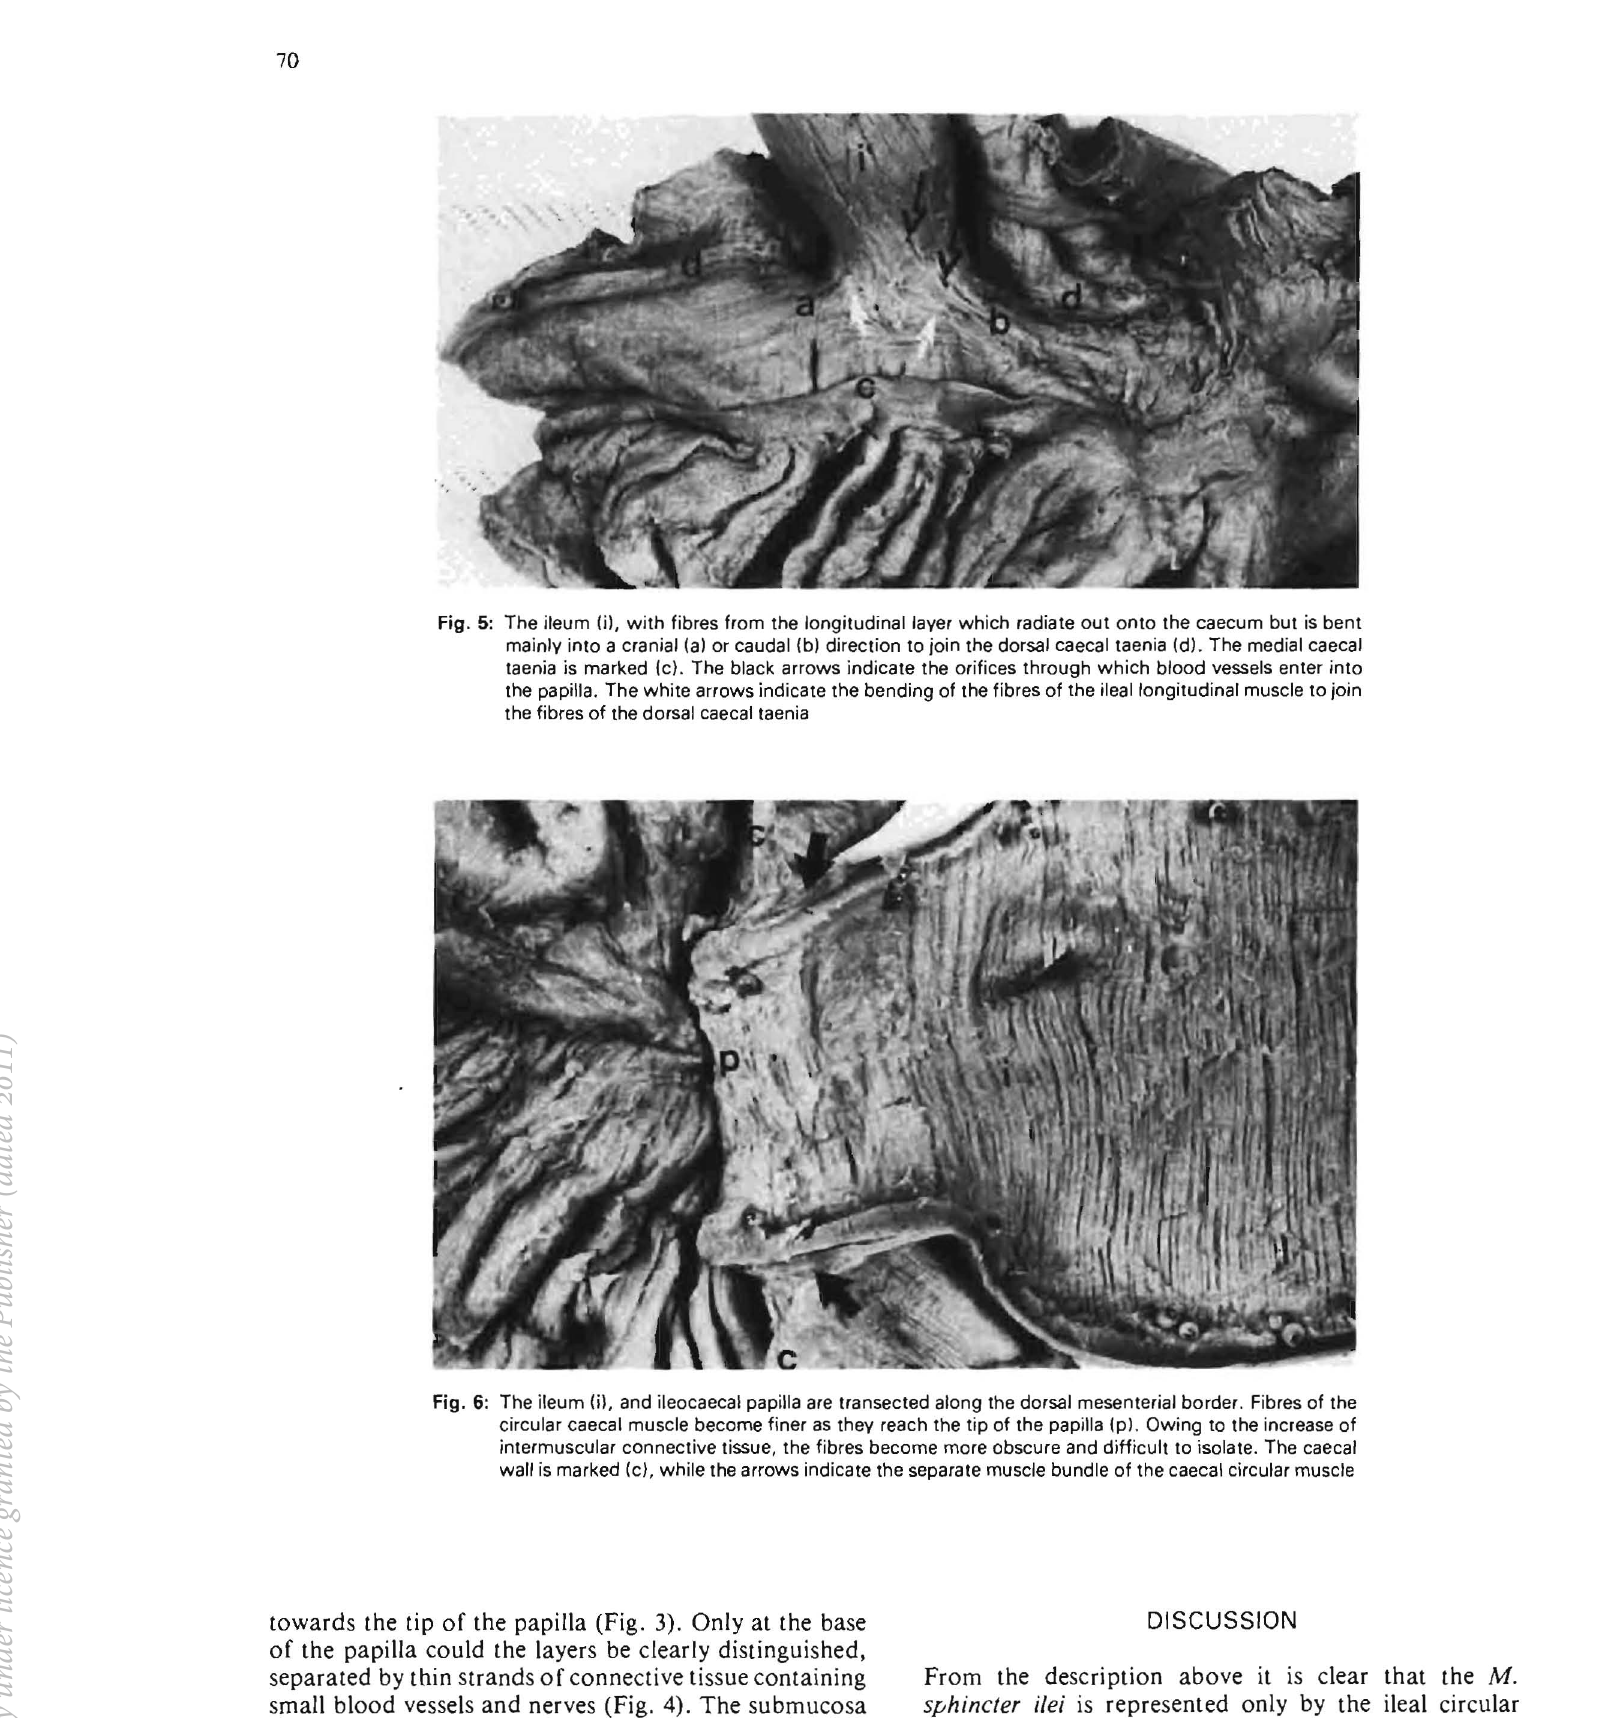
Fig. 5: The ileum (i), with fibres from the longitudinal layer which radiate out onto the caecum but is bent mainly into a cranial (a) or caudal (b) direction to join the dorsal caecal taenia (dl. The medial caecal taenia is marked (c). The black arrows indicate the orifices through which blood vessels enter into the papilla. The white arrows indicate the bending of the fibres of the ileal longitudinal muscle to join the fibres of the dorsal caecal taenia